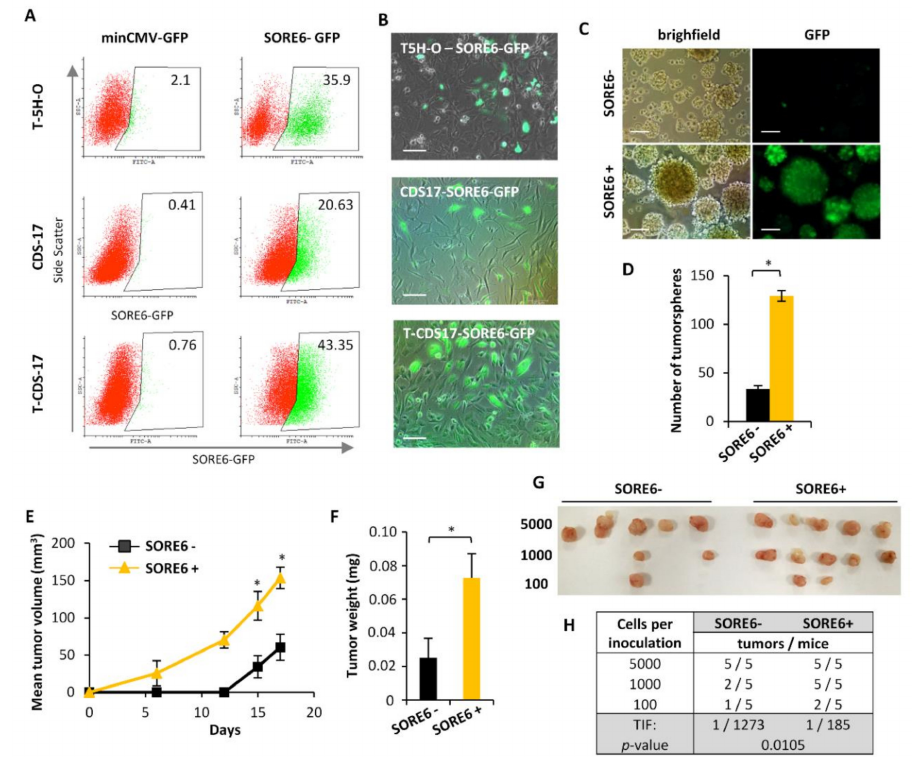
Figure 4. SORE6 activity marks a subpopulation of CSCs in sarcoma. ( A ) Flow-cytometry analysis showingthelevelofSORE6 + cellsinT-5H-O-SORE6-GFP,CDS17-SORE6-GFPandT-CDS17-SORE6-GFP cultures or its corresponding minCMV-GFP control cells. ( B ) Fluorescence microscopy images showing cell subpopulations presenting GFP-associated SORE6 activity. Scale bars = 50 µ m ( C , D ) Tumorsphere formation assay performed on SORE6 + and SORE6 − cells. Representative images ( C ) and the quantification of number of tumorspheres generated in three independent experiments ( D ) are shown. Scale bars = 200 µ m ( E , F ) In vivo tumor formation ability of SORE6 + and SORE6- subpopulations of T-5H-O-SORE6-GFP cells. ( E ) Tumor growth kinetics observed after inoculation of immunodeficient mice with 1 × 10 4 cells of each population (n = 8 mice per series). ( F ) Average tumor weight at the end of the experiment. ( G , H ) In vivo limit dilution assay (LDA) to evaluate the tumor forming potential of SORE6 + and SORE6- T-5H-O-SORE6-GFP cells. ( G ) Images of the tumors formed in both series upon the inoculation of 5000, 1000 or 100 cells. ( H ) Quantification of the frequency of tumor initiating (TIF) cells using the ELDA software. The number of mice that grew tumors after 4 weeks and total number of inoculated mice for each condition is indicated. Error bars represent the standard deviation and asterisks indicate statistically significant di ff erences (*: p < 0.05 by two-sided Student t